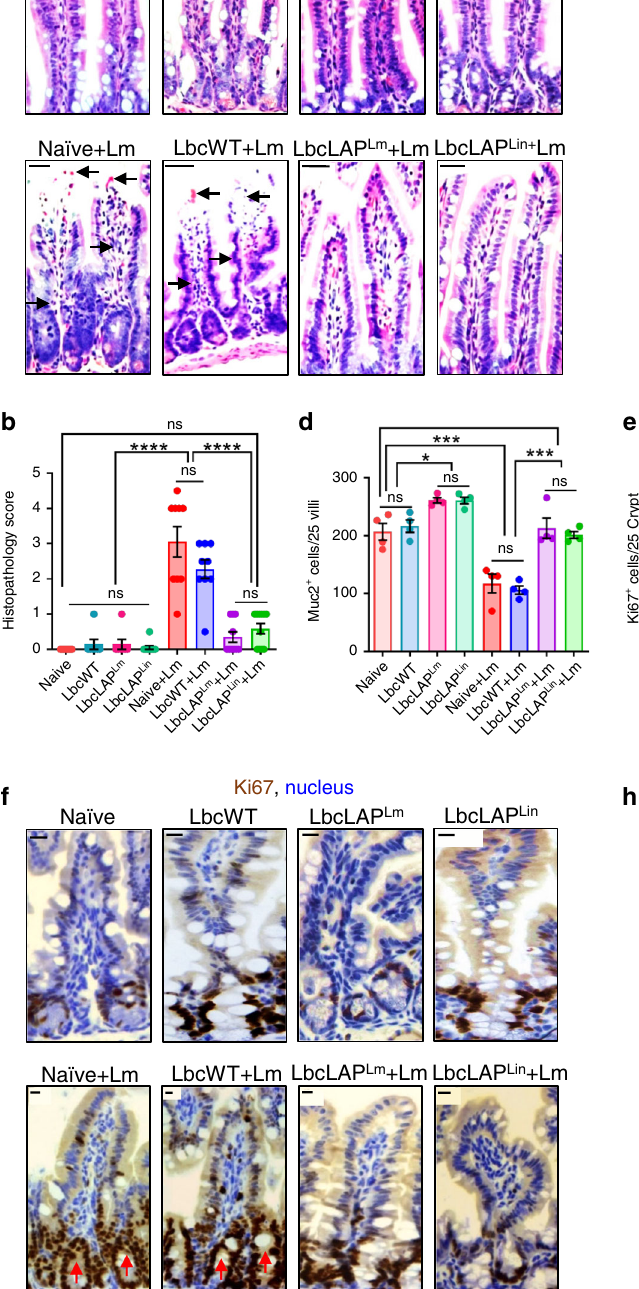
with the increased Lm burdens (Fig. 2f – j), in fl ammation and histopathology scores (Fig. 5a, b). In contrast, relative to naive mice, the population of F4/80 + macrophages did not change signi fi cantly in BLP-treated mice pre or post Lm challenge (Supplementary Fig. 9a). Increased numbers of CD3 + T cells (~80%) were observed in BLP-treated mice pre-Lm challenge and were maintained in these mice post Lm challenge, relative to naive mice (Supplementary Fig. 9b). Subset analyses of T cells showed fewer CD8 + T cells in BLP-treated mice 48 h post